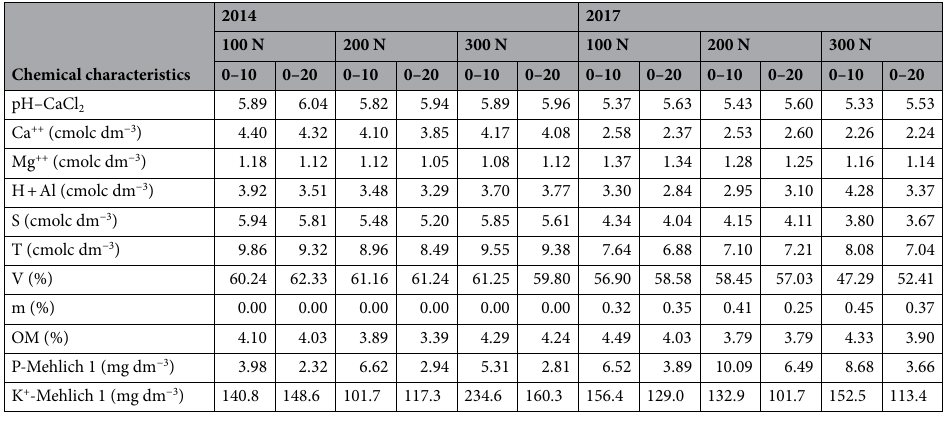
Table 1. Chemical characteristics (0–10 cm and 0–20 cm) throughout the experimental period. S = bases sum; T = cation exchange capacity (pH7); V = base saturation; m = aluminum saturation; OM = organic